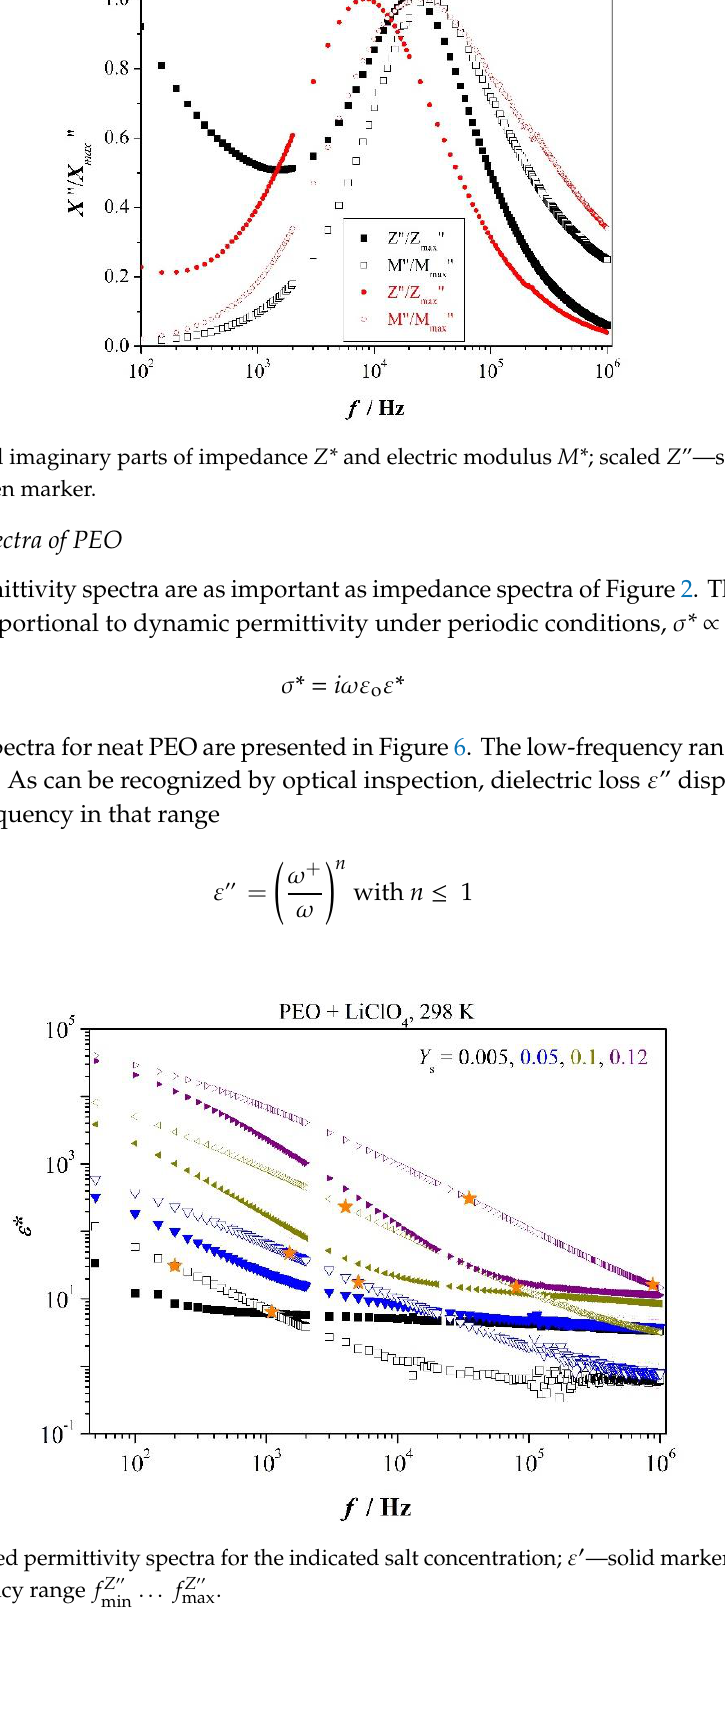
(cid:48)(cid:48) ... f Z (cid:48)(cid:48) max min f … "Z f . min max